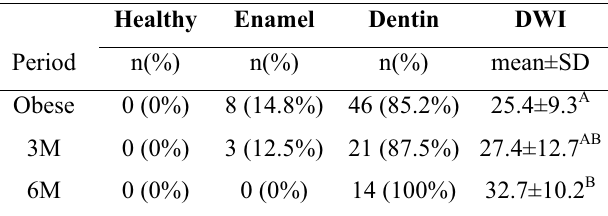
TABLE 3 - Distribution of patients according to DWI index